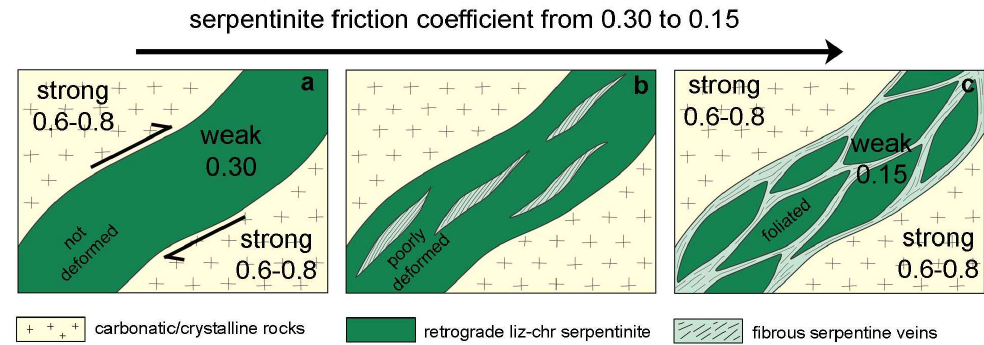
Figure 9. Schematic cartoon of possible evolution of strain localisation and frictional strength in retrograde serpentinites. ( a – c ) Strain localisation in serpentinites and mechanical evolution from undeformed retrograde serpentinites (μ = 0.3) to foliated, lizardite-rich serpentinites (μ = 0.18), respectively. In ( c ), the pervasive occurrence of anastomosing ultraweak slickenfibre faults, mostly formed by chrysotile and polygonal serpentine may result in further weakening (μ = 0.15). Strain localisation in serpentinite triggers two main processes that feedback into a progressive weakening: (1) pressure solution within massive and foliated serpentinite; and (2) precipitation of new ultraweak serpentines in slickenfibre veins/faults. Preferential dissolution of mesh cores and of unfavourably oriented lizardite rims determines the progressive evolution from undeformed retrograde serpentinites ( = 0.3; Figure 4) to foliated serpentinites (Figure 5). The latter mostly consist of frictionally weak lizardite ( = 0.18), which forms an interconnected network of subparallel (001) lamellae (lizardite “ribbons” in Figures 5e,f) with (001) planes parallel to shear direction. This microstructure enhances pervasive and easy sliding parallel to (001) basal planes. We therefore expect that the evolution from undeformed to foliated serpentinites with strong CPO may result in further weakening from μ of 0.3 to 0.18. Friction experiments on favourably oriented solid samples of lizardite-rich foliated serpentinite should be performed in the future to verify possible fabric-induced weakening in serpentinites (e.g., [83]).